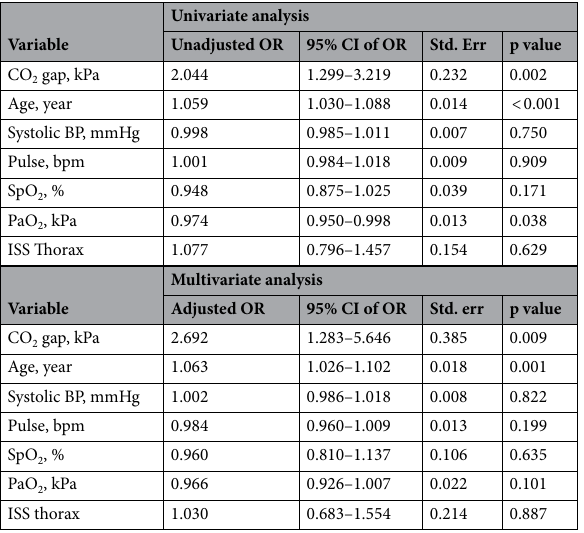
Table 3. Logistic regression models of survival. Complete case analysis available for 93 patients (multivariate). Twelve patients were excluded from the multivariate analysis due to missing data (see Table 1). Units of measure and abbreviations as described in Tables 1 and 2.